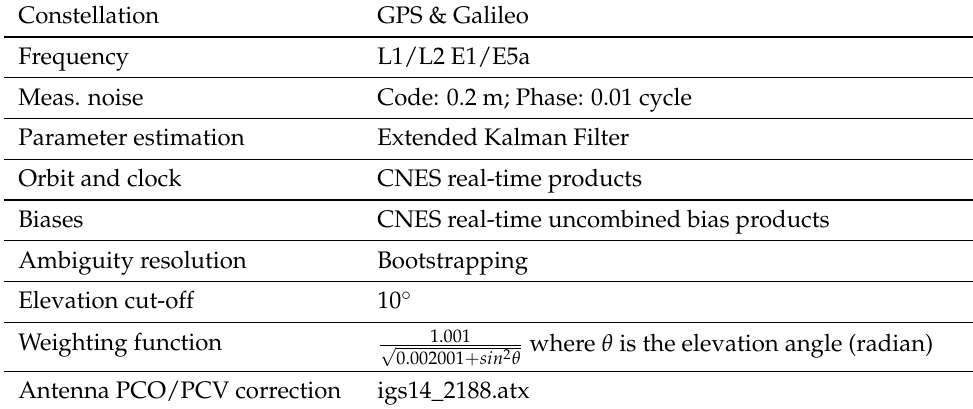
Table 2. POINT PPP